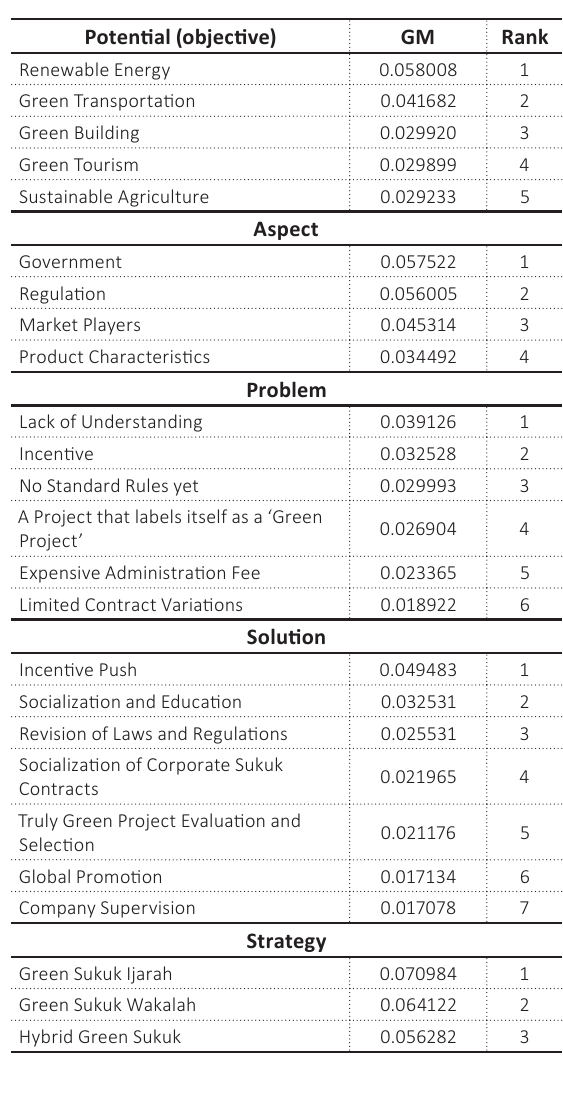
Table 2. Super decision processing